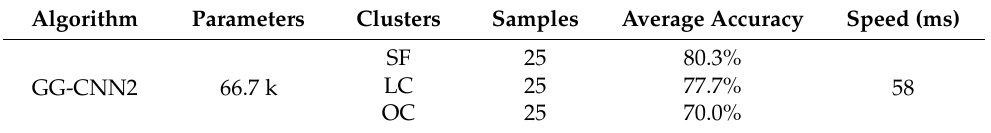
Table 1. Performance results of grasp network.